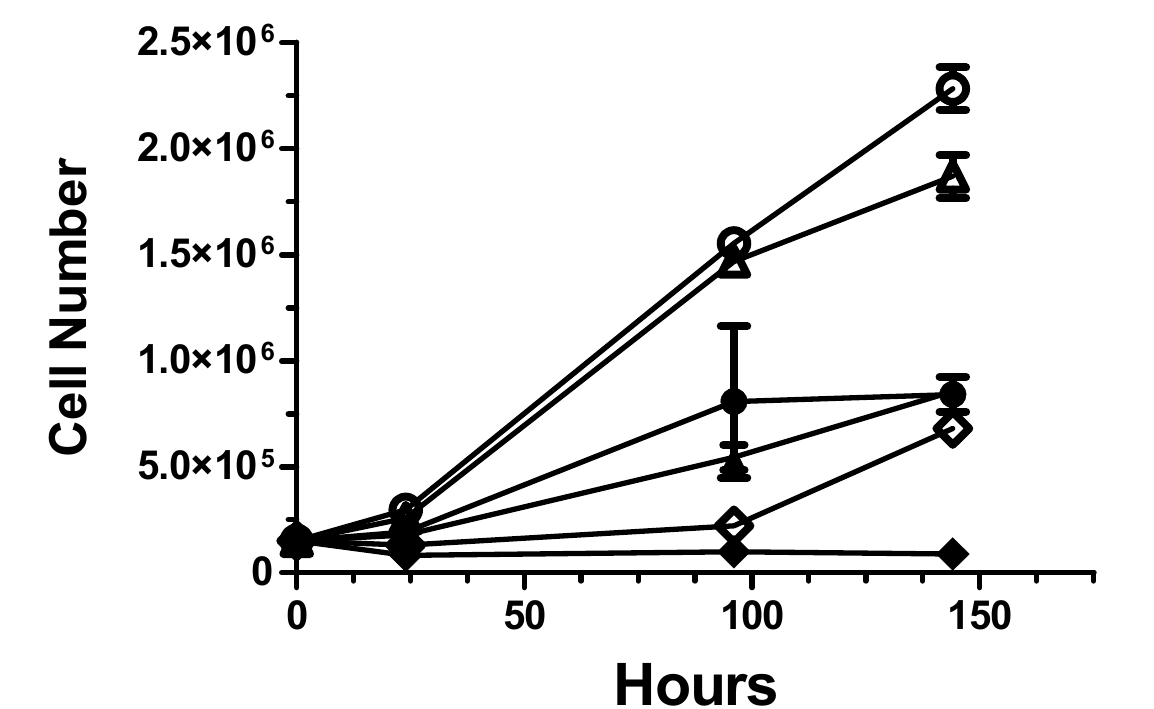
Figure 8. Opaganib sensitizes PAN02 cells to killing by radiation In vitro. Cells were plated and treated with 0 (open symbols) or 10 µ M (filled symbols) opaganib and 0 ( , ● ), 5 ( , ▲ ) or 15 ( , ) Gy of radiation. At the indicated times, viable cell numbers were counted using the trypan blue exclusion assay.